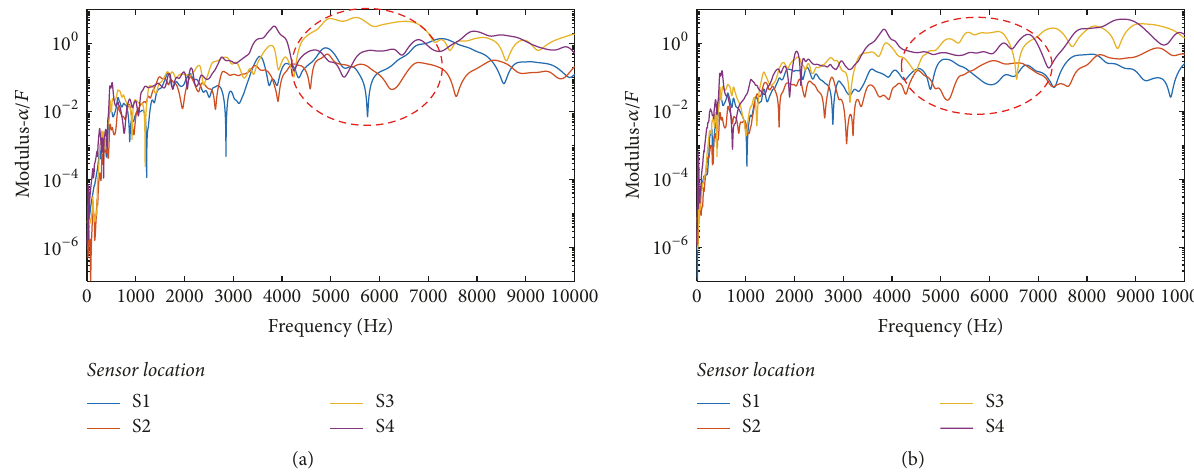
Figure 15: Simulated FRFs obtained in four different sensor locations, exciting from (a) B1 and (b) B3.